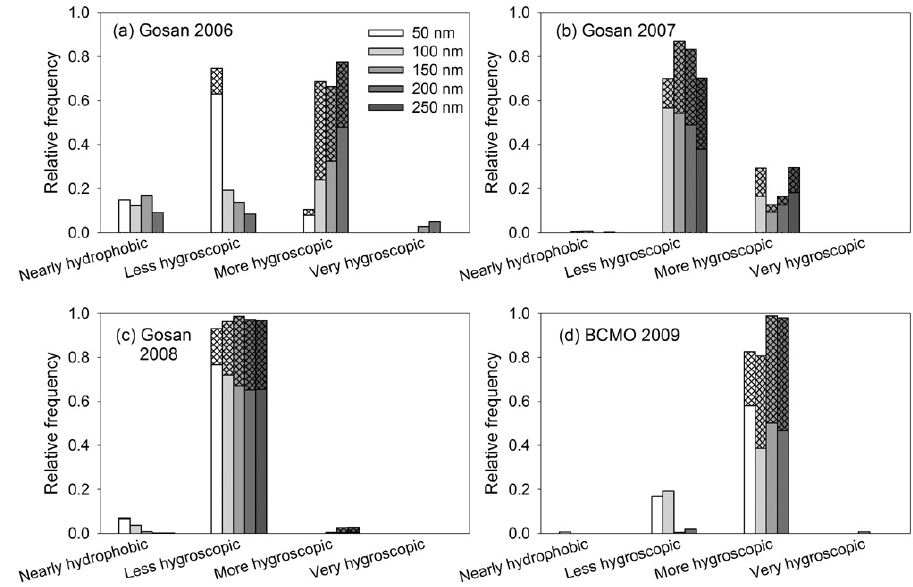
Fig. 7. Relative frequency of occurrence of each hygroscopicity class for each dry diameter during each campaign. Meshed part indicates the portion for pollution days. For BCMO 2009, dry diameters are 53, 113, 163, 225nm.